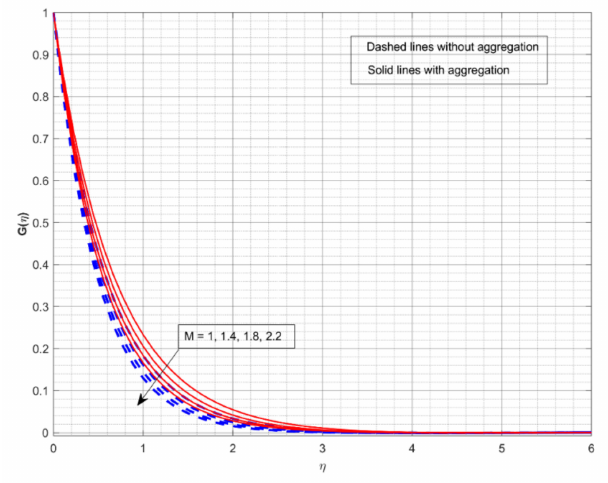
Figure 3. The impact of magnetic parameter on the velocity profile G ( η ) .